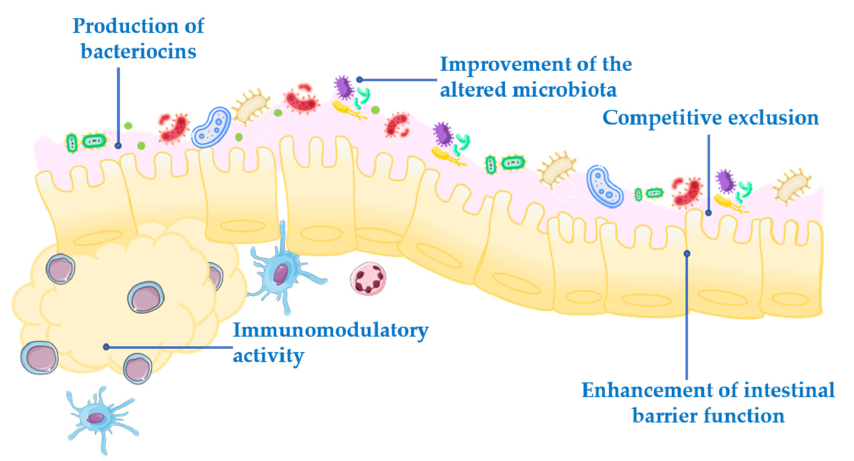
Figure 1. Mechanism of action of probiotics.